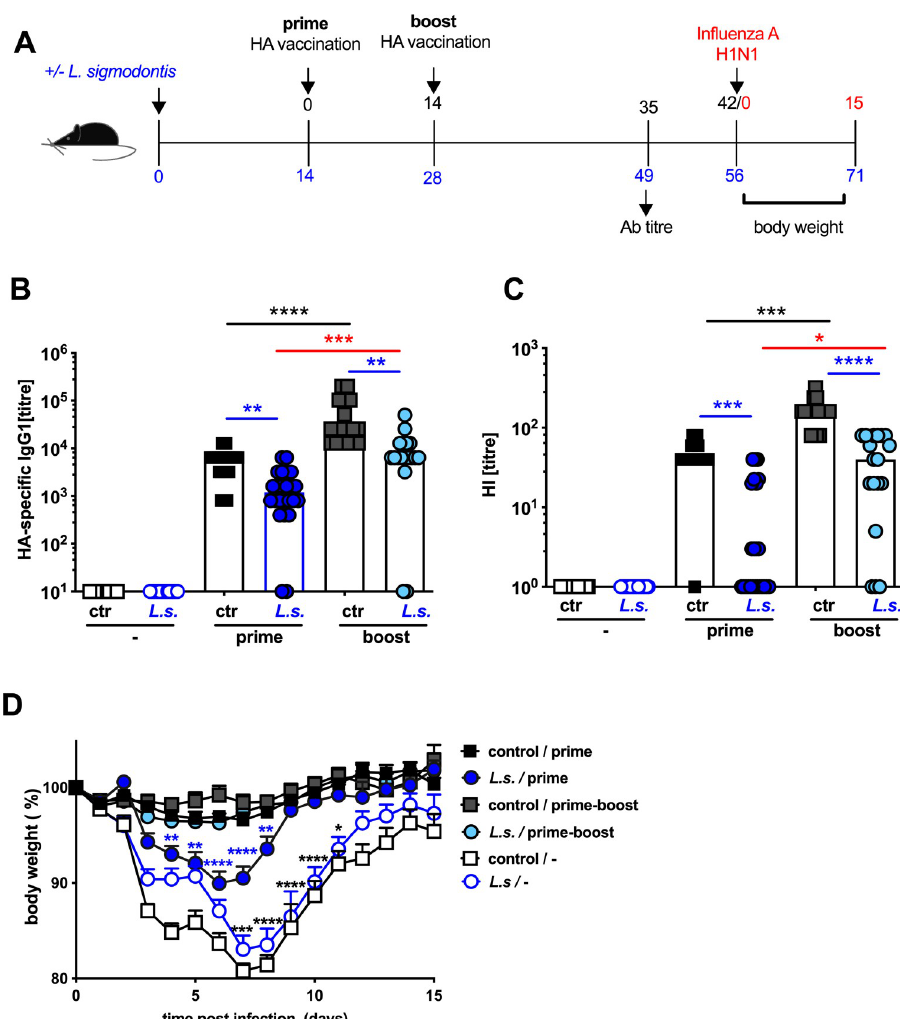
Fig 1. Prime-boost influenza vaccination protects L . sigmodontis -infected mice from challenge infection-induced weight loss. (A) Experimental design: C57BL/6 mice were left na ï ve (black and grey squares) or naturally infected with L . sigmodontis (light and dark blue circles). Mice either received a control injection (open symbols) or were i.p. vaccinated with non-adjuvanted influenza vaccine Begripal season 2017/18 (black squares, dark blue circles) either once at day 14 post L . sigmodontis infection or in a prime-boost regimen (grey squares, light blue circles) at day 14 and day 28 post L . sigmodontis infection. (B) Titres of HA-specific IgG1 and (C) HI titres were quantified 21 days after the last vaccination. (D) All mice were i.n. infected with 1 x 10 3 PFU 2009 pH1N1 influenza A 1 week later and body weight was recorded daily over 15 days. (BC) show combined results of 3 independent experiments with n � 6 per group. Each symbol represents an individual mouse, the bars show the median. (D) shows combined results out 3 independent experiments with n � 4 per group and experiment. Symbols show the mean per group at the indicated time point, error bars show SD. Asterisks indicate statistically significant differences applying (BC) Kruskal-Wallis test (p > 0.001) with Dunn’s multiple comparison test comparing all vaccinated groups with each other ( � p � 0.05, �� p � 0.01, ��� p � 0.001, ���� p � 0.0001; black asterisks: na ï ve control single-vaccinated group to na ï ve control prime- boost-vaccinated group, blue asterisks: L . sigmodontis -infected single- or prime-boost-vaccinated groups to na ï ve control single- or prime-boost-vaccinated groups, red asterisks: L . sigmodontis -infected single-vaccinated to L . sigmodontis -infected prime-boost vaccinated groups. (D) shows 2-way ANOVA with Sidak‘s multiple comparison test comparing the control single-vaccinated group to L . sigmodontis -infected, single-vaccinated group (blue asterisks) and the L . sigmodontis -infected single-vaccinated group to L . sigmodontis -infected non-vaccinated group (black asterisks).